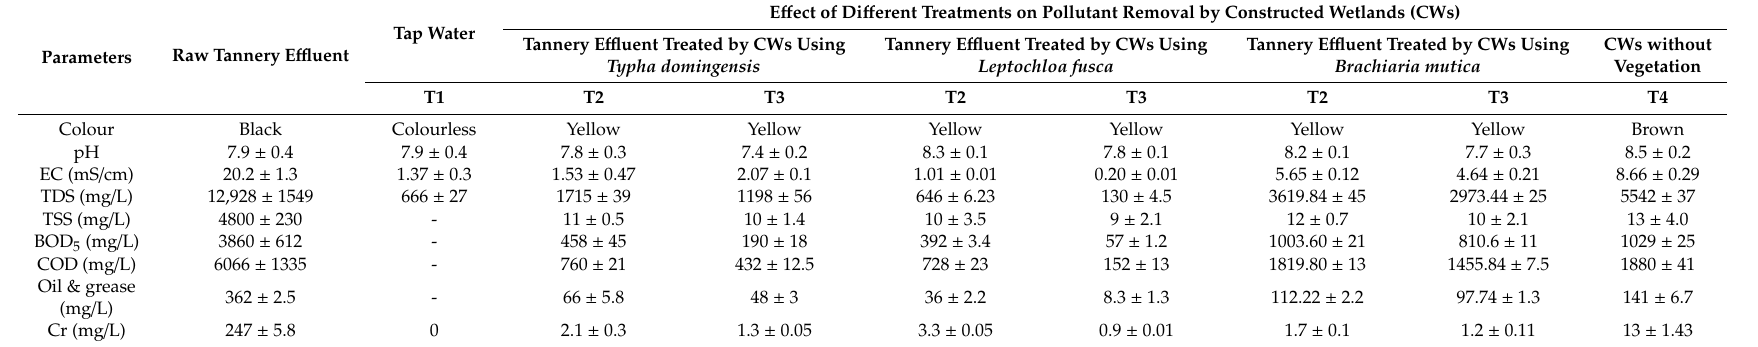
Table 1. Physico-chemical characterization of untreated and treated tannery e ffl uent.